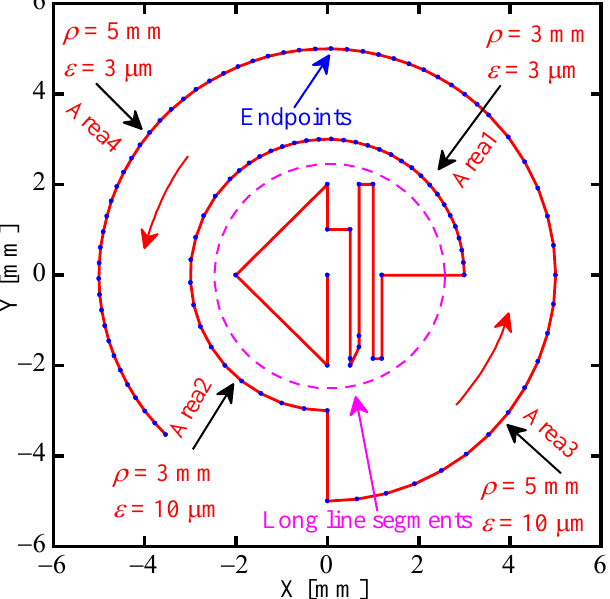
Figure 6. The 2D machining path of the continuous small line segments.